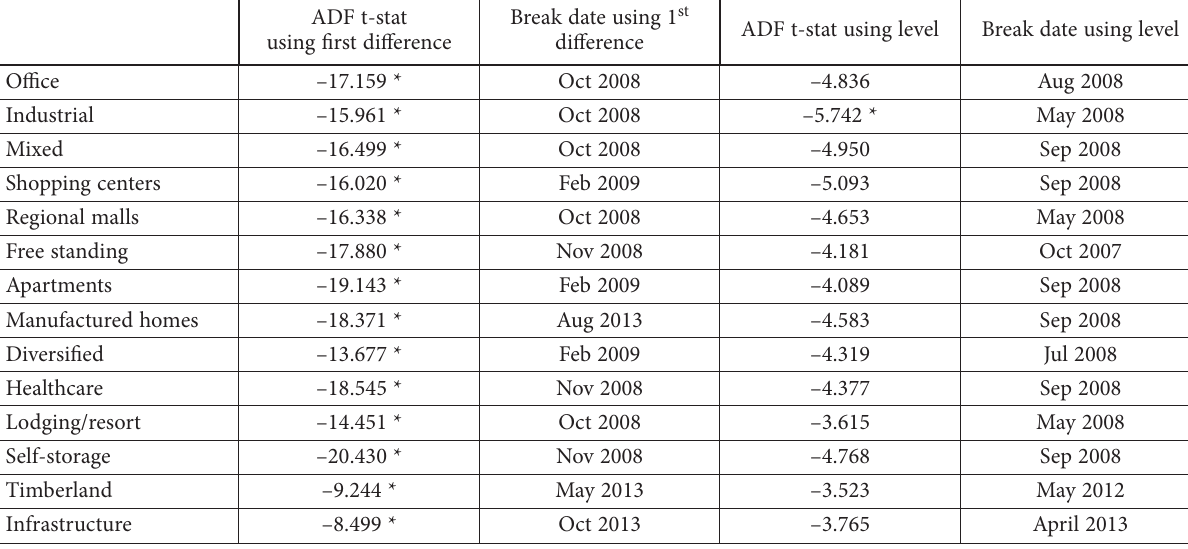
Table 10. Unit root tests results with the possibility of structural breaks using Vogelsang and Perron